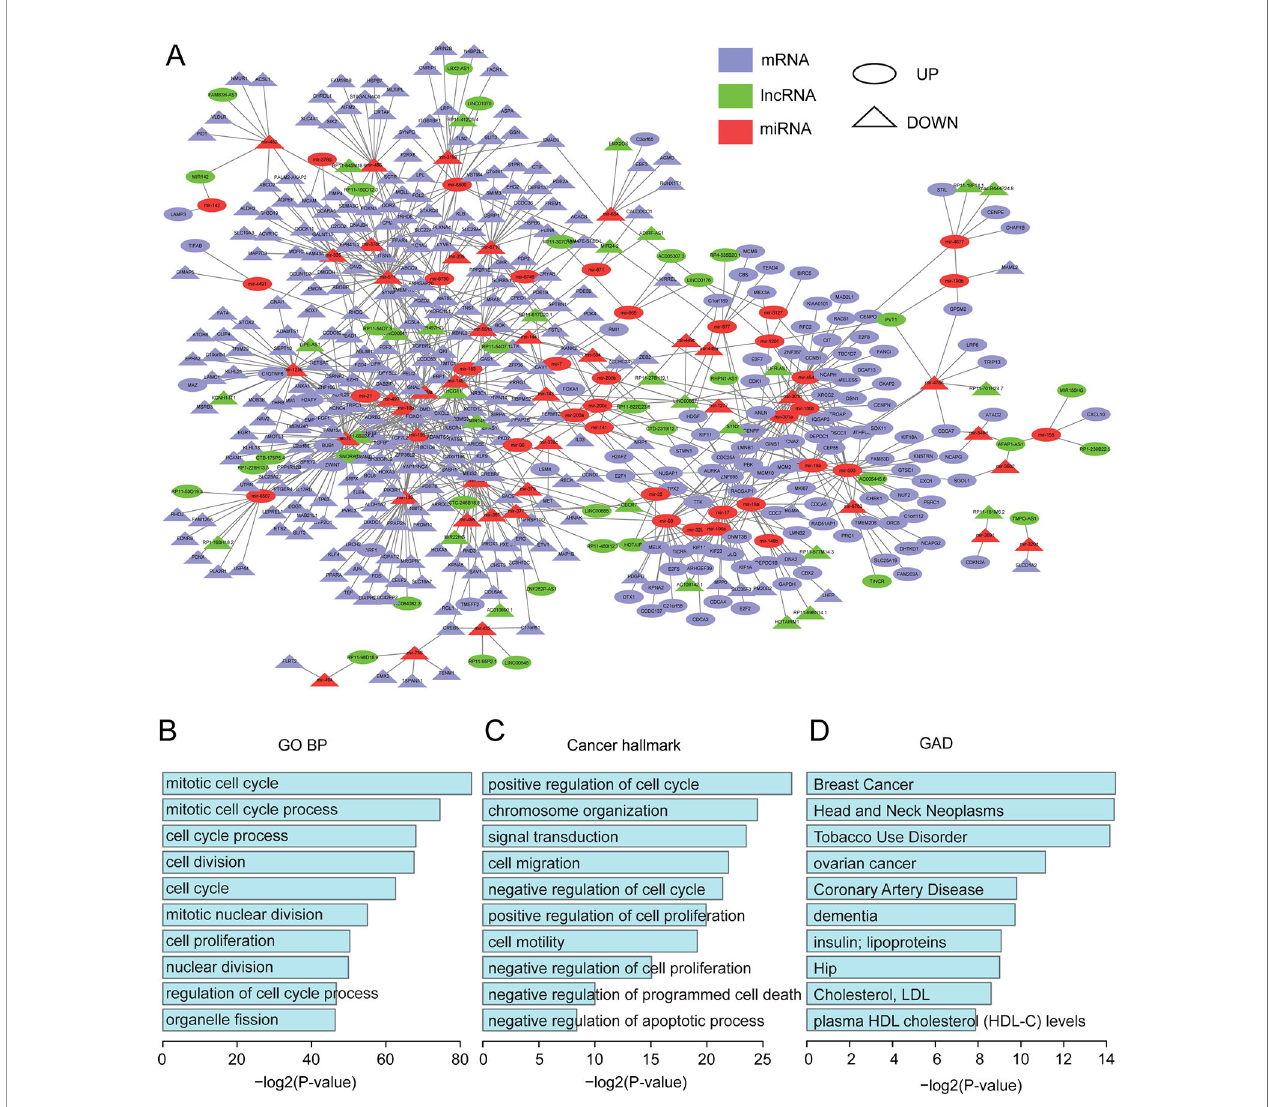
FIGURE 2 | Functional analysis for the dysregulated network. (A) The dysregulated lncRNA-miRNA-mRNA network. The network was visualized using Cytoscape. (B) The top 10 enriched GO terms. (C) The top 10 enriched cancer hallmark-related GO terms. (D) The top 10 enriched GAD